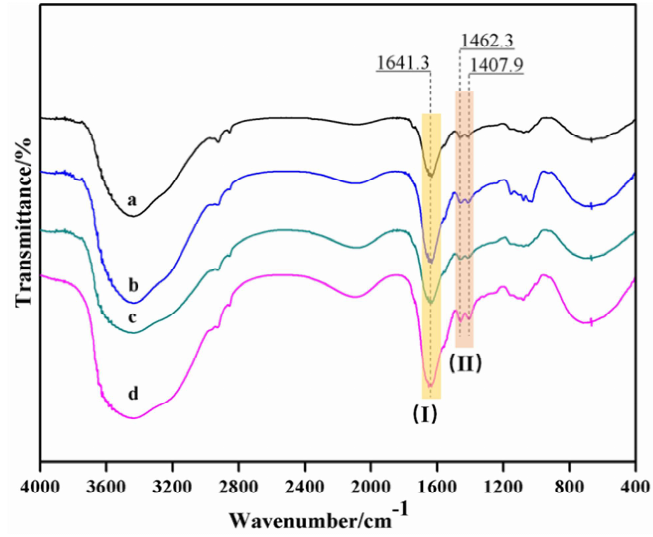
Figure 1. FT-IR spectrogram of Camellia oleifera cake-protein hydrolysates. Note: a. Camellia oleifera cake-protein hydrolysate; b. SPI/ Camellia oleifera cake-protein compound hydrolysate; c. DSP/ Camellia oleifera cake-protein compound hydrolysate; d. Casein/ Camellia oleifera cake-protein compound hydrolysate; I. amide regions-I; II. amide regions-II.